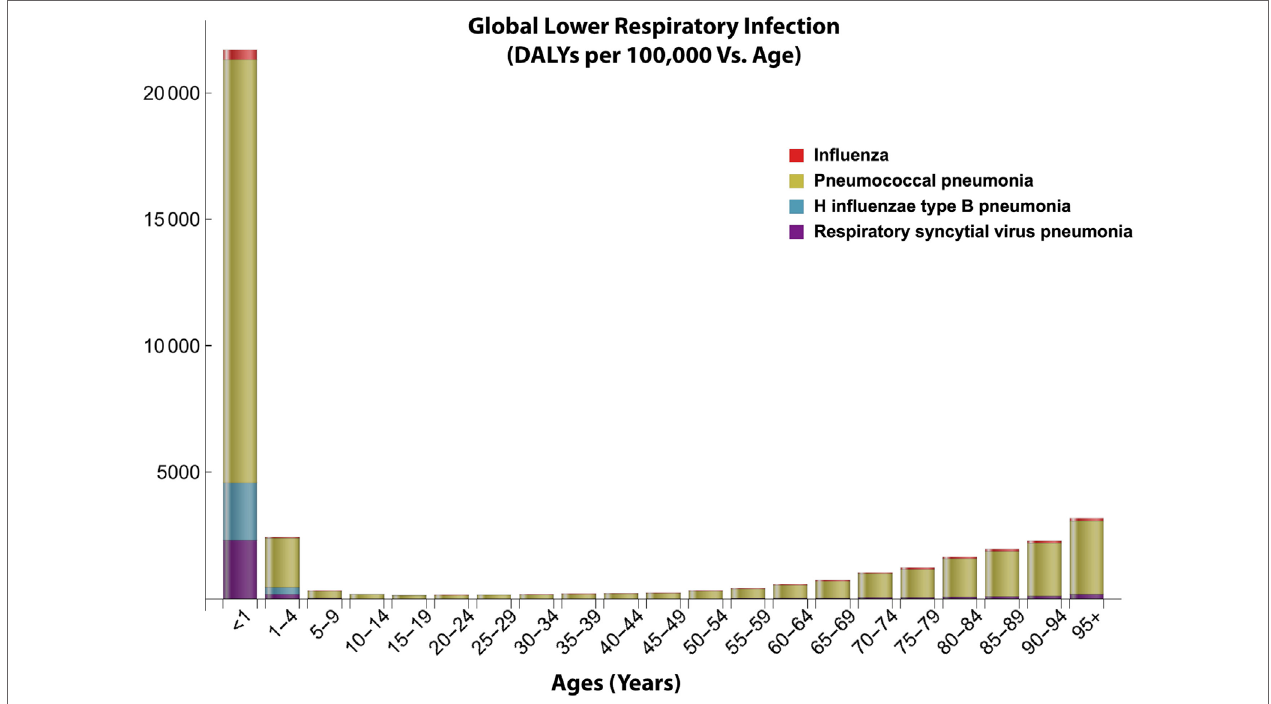
FigURe 2 | Global distribution of lower respiratory infections with age. This figure shows the age-dependent disease burden to lower respiratory infections especially pneumococcal pneumonia based on the disability adjusted life year (DALY) data from 2016. Data obtained from Institute for Health Metrics and Evaluation